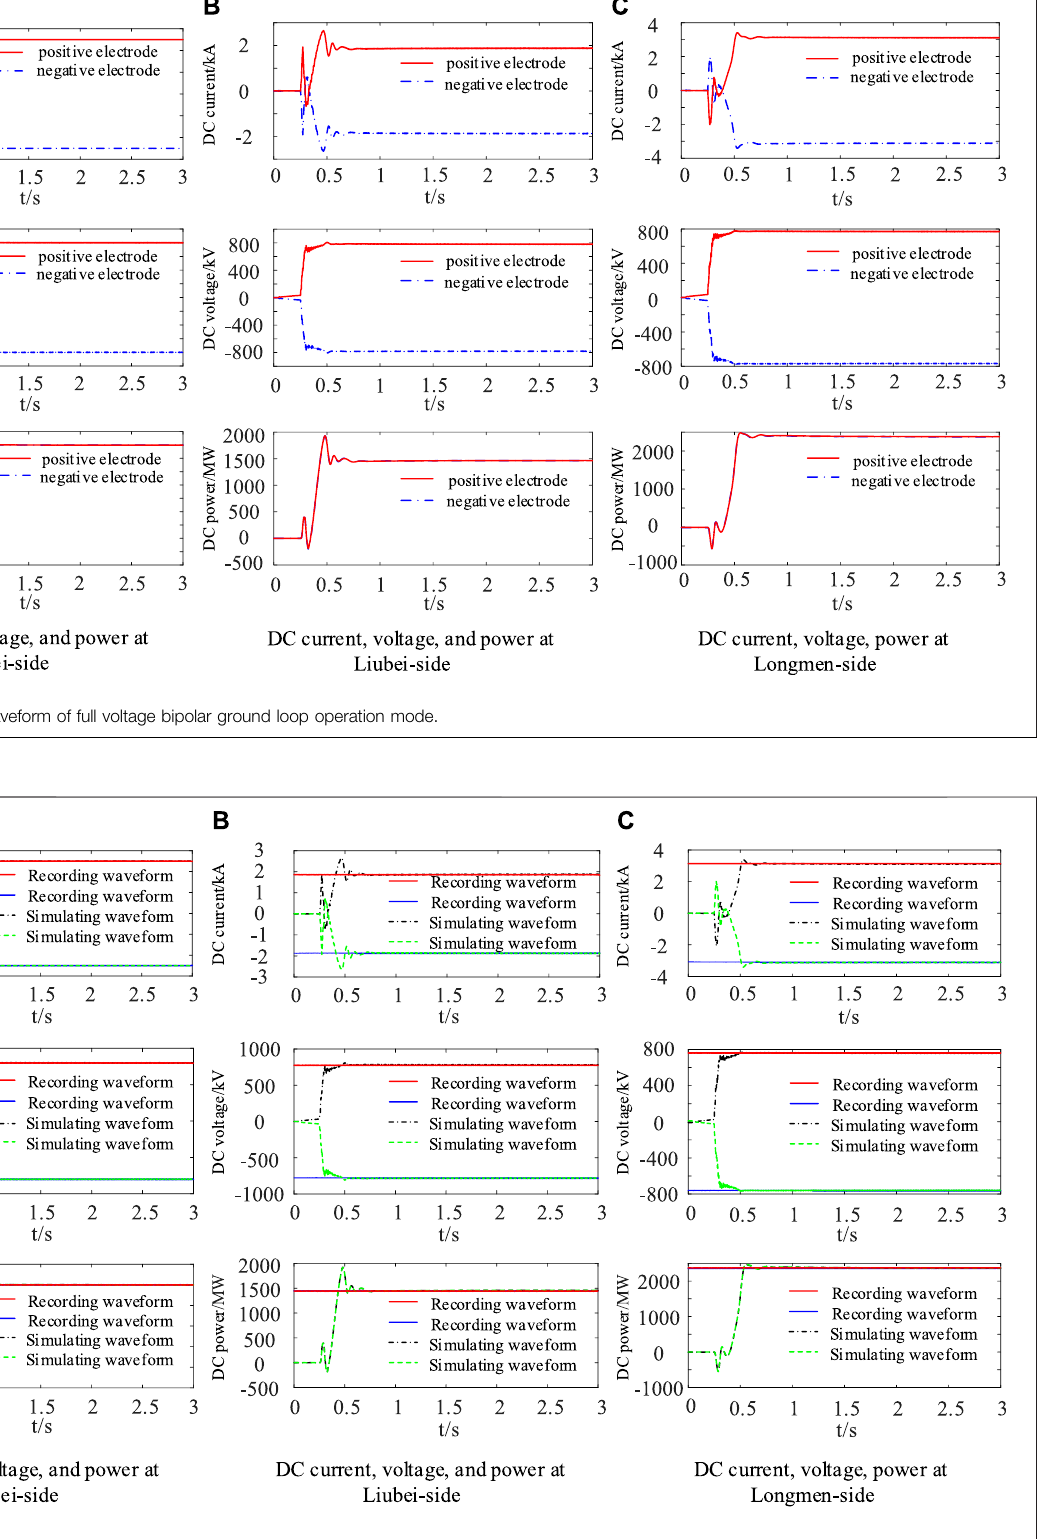
FIGURE 12 | Comparison of simulated waveforms and recorded waveforms in steady-state operation.